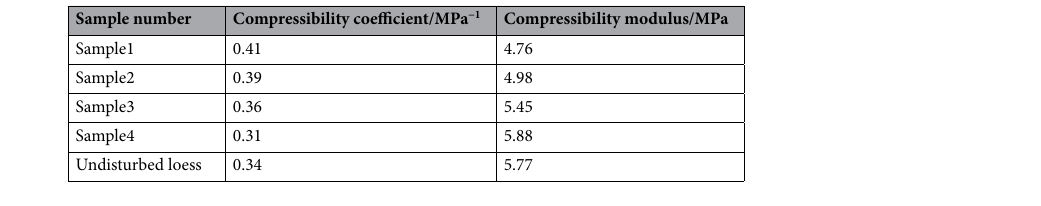
Table 6. Parameters of consolidation